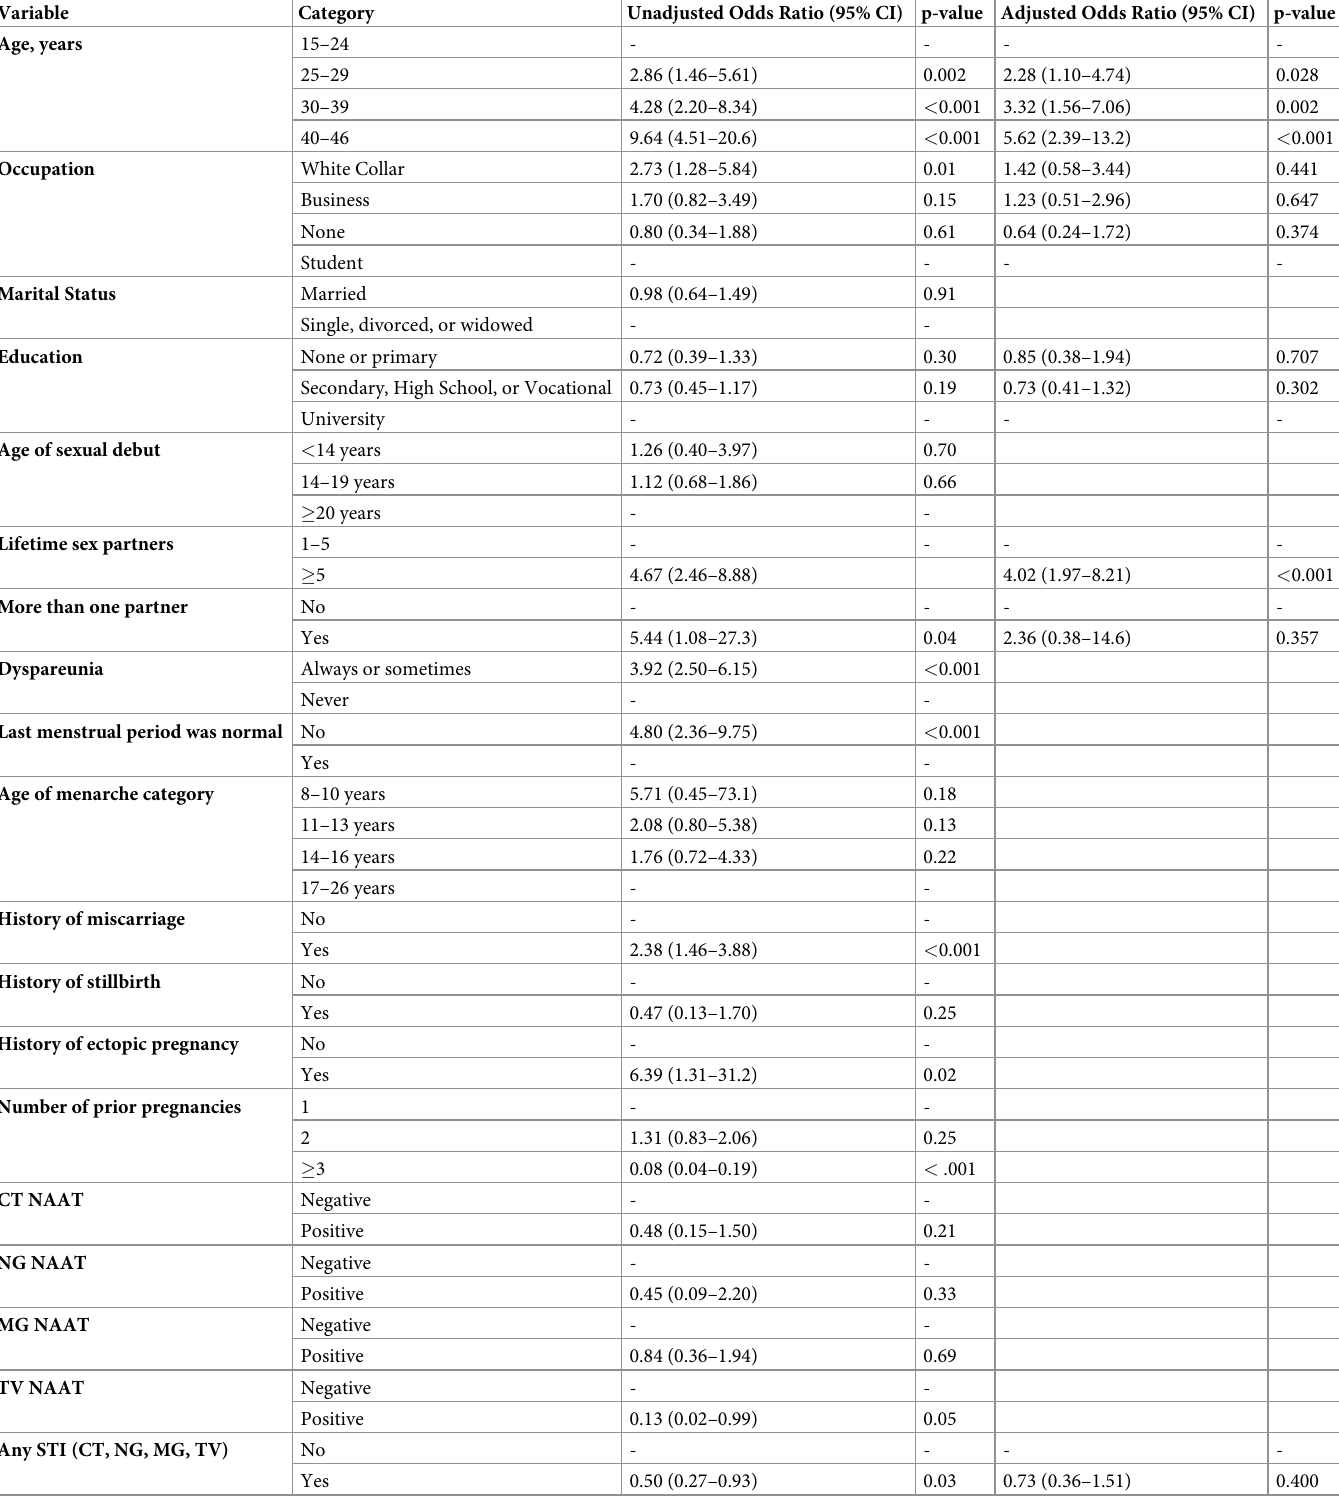
Table 2. Factors associated with secondary infertility in cameroon: Unadjusted and adjusted models.